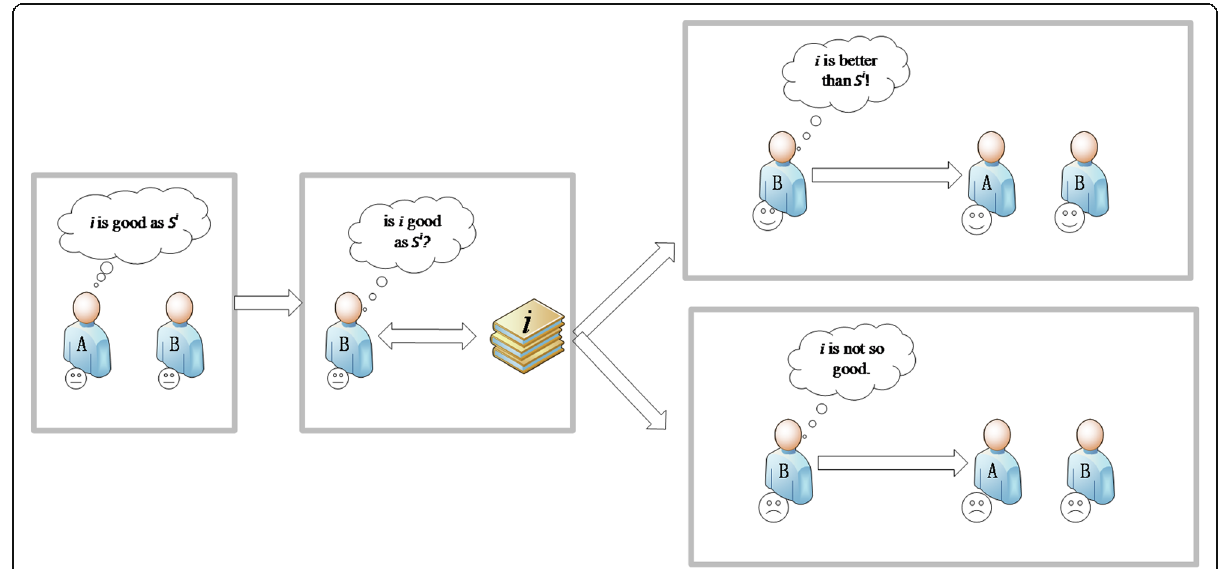
Fig. 1 Relationship between recommendation and